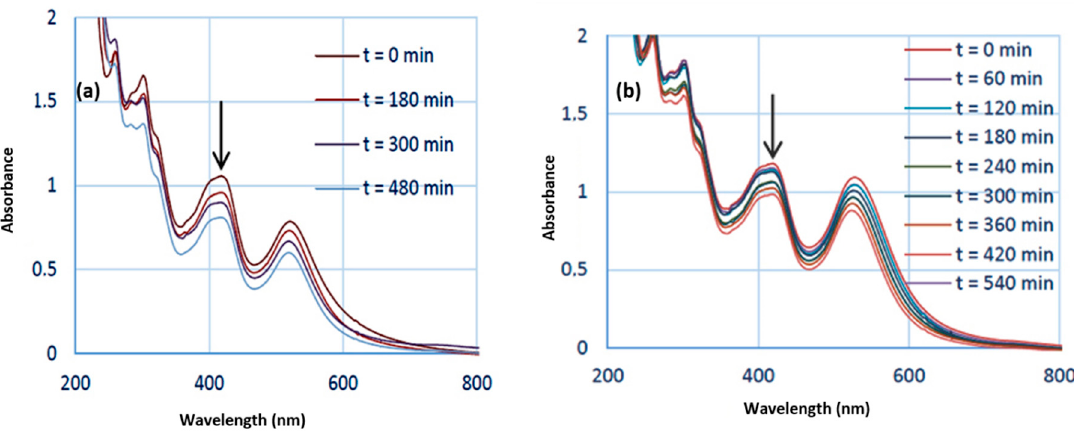
Figure 7. Temporal evolution of the UV-visible spectra of deaerated aqueous solutions containing 5 × 10 − 4 M potassium hexacyanoferrate under LEDs irradiated at 520 nm ( a ) in the presence of 15 nm Au-NPs@citrate and ( b ) 30 nm Au-NPs@citrate. Optical path length: 1 cm.